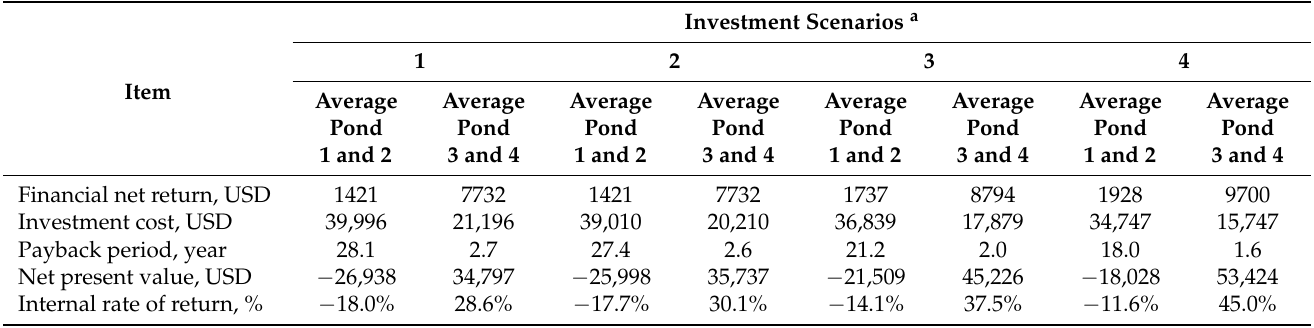
Table 13. Financial measures of profitability for the four investment scenarios producing foodsize and stocker hybrid catfish, channel catfish Ictalurus punctatus raceway systems (IPRS), per raceway placed in a 0.4 ha pond, 2018.